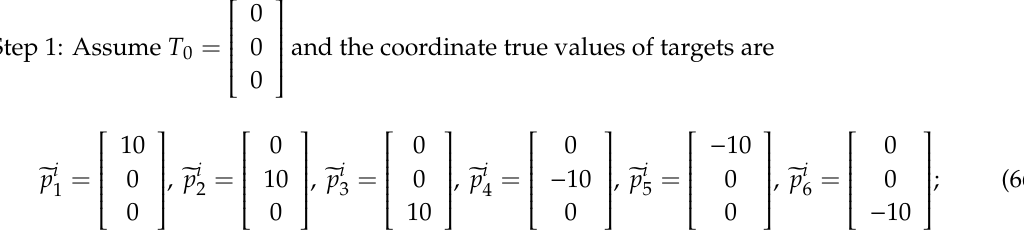
Figure 1. The target geometry of experiment I.